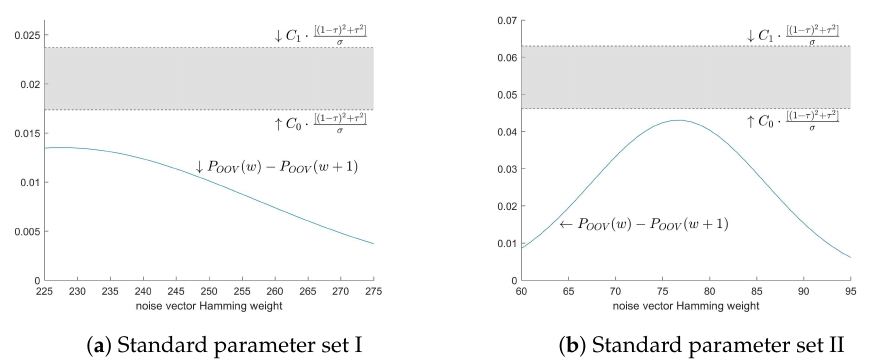
Figure 5. The approximation error upper bound is larger than the interval widths used in the attack. Thus, the adversary may not be capable to accurately estimate noise vectors weights.